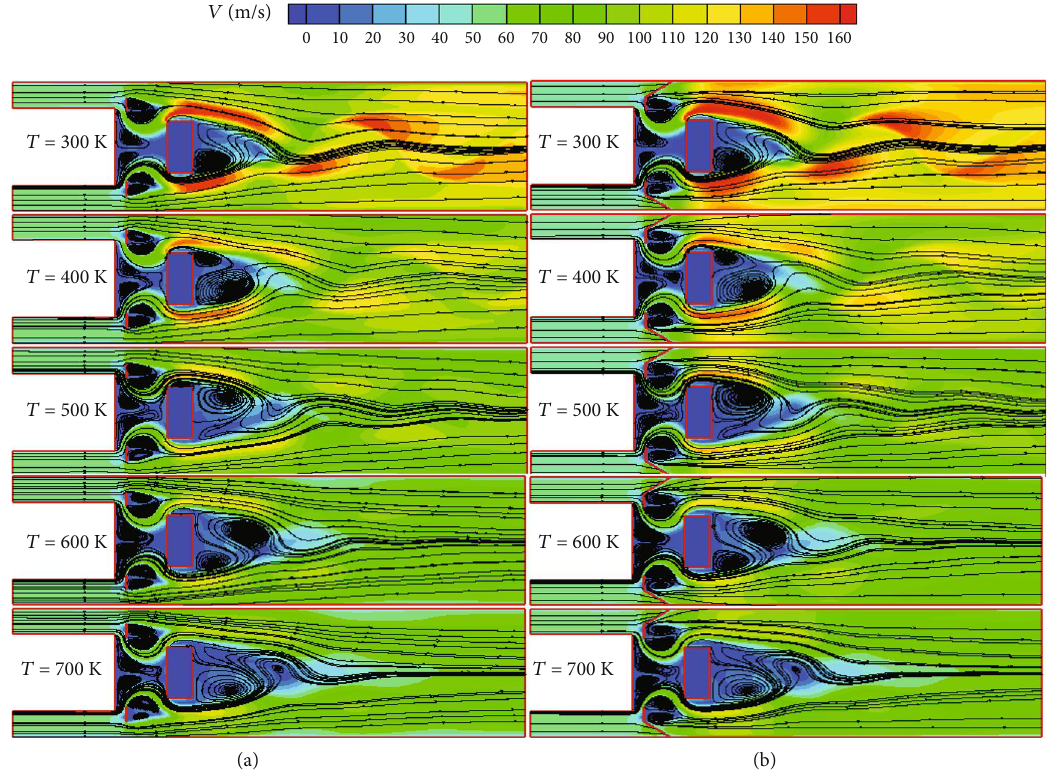
Figure 28: Velocity fi eld under di ff erent inlet